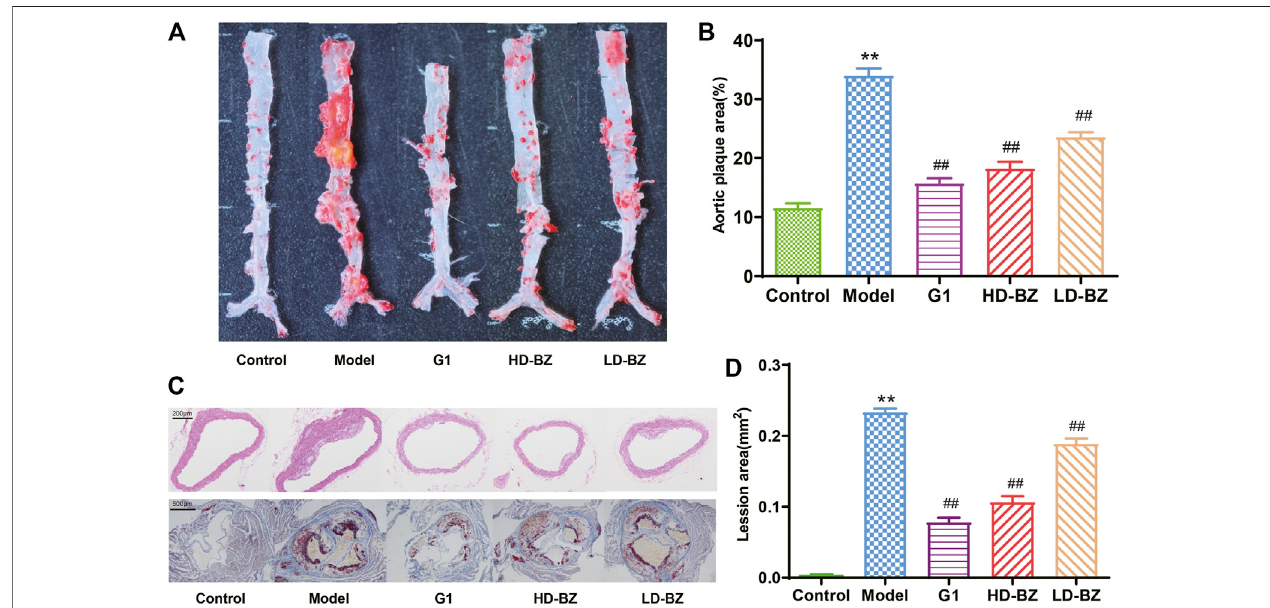
FIGURE 1 | Effects of BZBS on atherosclerotic plaque formation in Ovx/ApoE -/- mice. (A) En face staining of aortas with oil red O. (B) Quanti fi cation of the plaque area as measured in A. (C) Light microscopy images (40 × ) of aortic roots stained with H&E and oil red O. (D) Quanti fi cation of the lesion areas as measured in C. ** p < 0.01 vs. the control group; ## p < 0.01 vs. the model group ( n (cid:1) 4 –